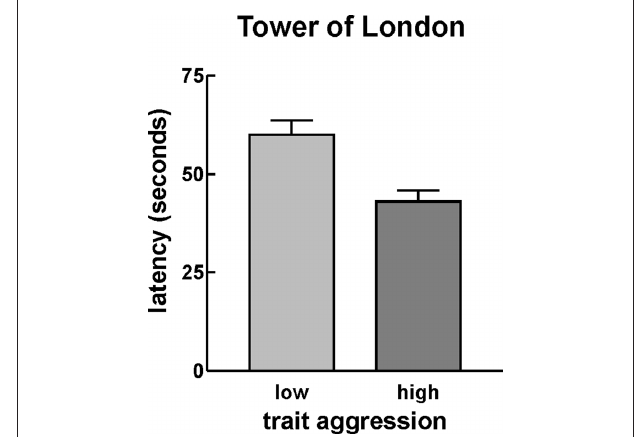
FiguRE 1 | Average latency (seconds) in the Tower of London task separately for low (left) and high (right) trait aggressive participants. High trait aggressive participants showed a reduced latency of the first move in the ToL paradigm. Error bars